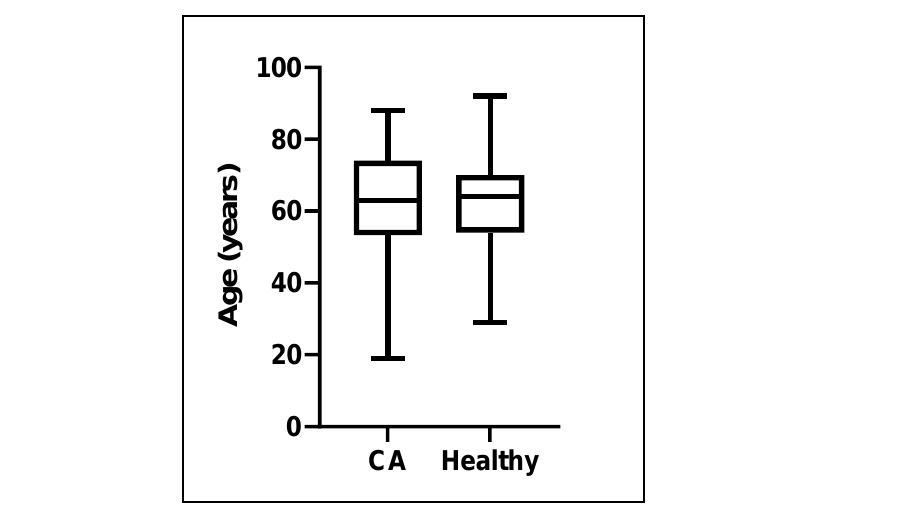
Figure A2. Sex distribution. Abbreviations: CA: cardiac arrest.